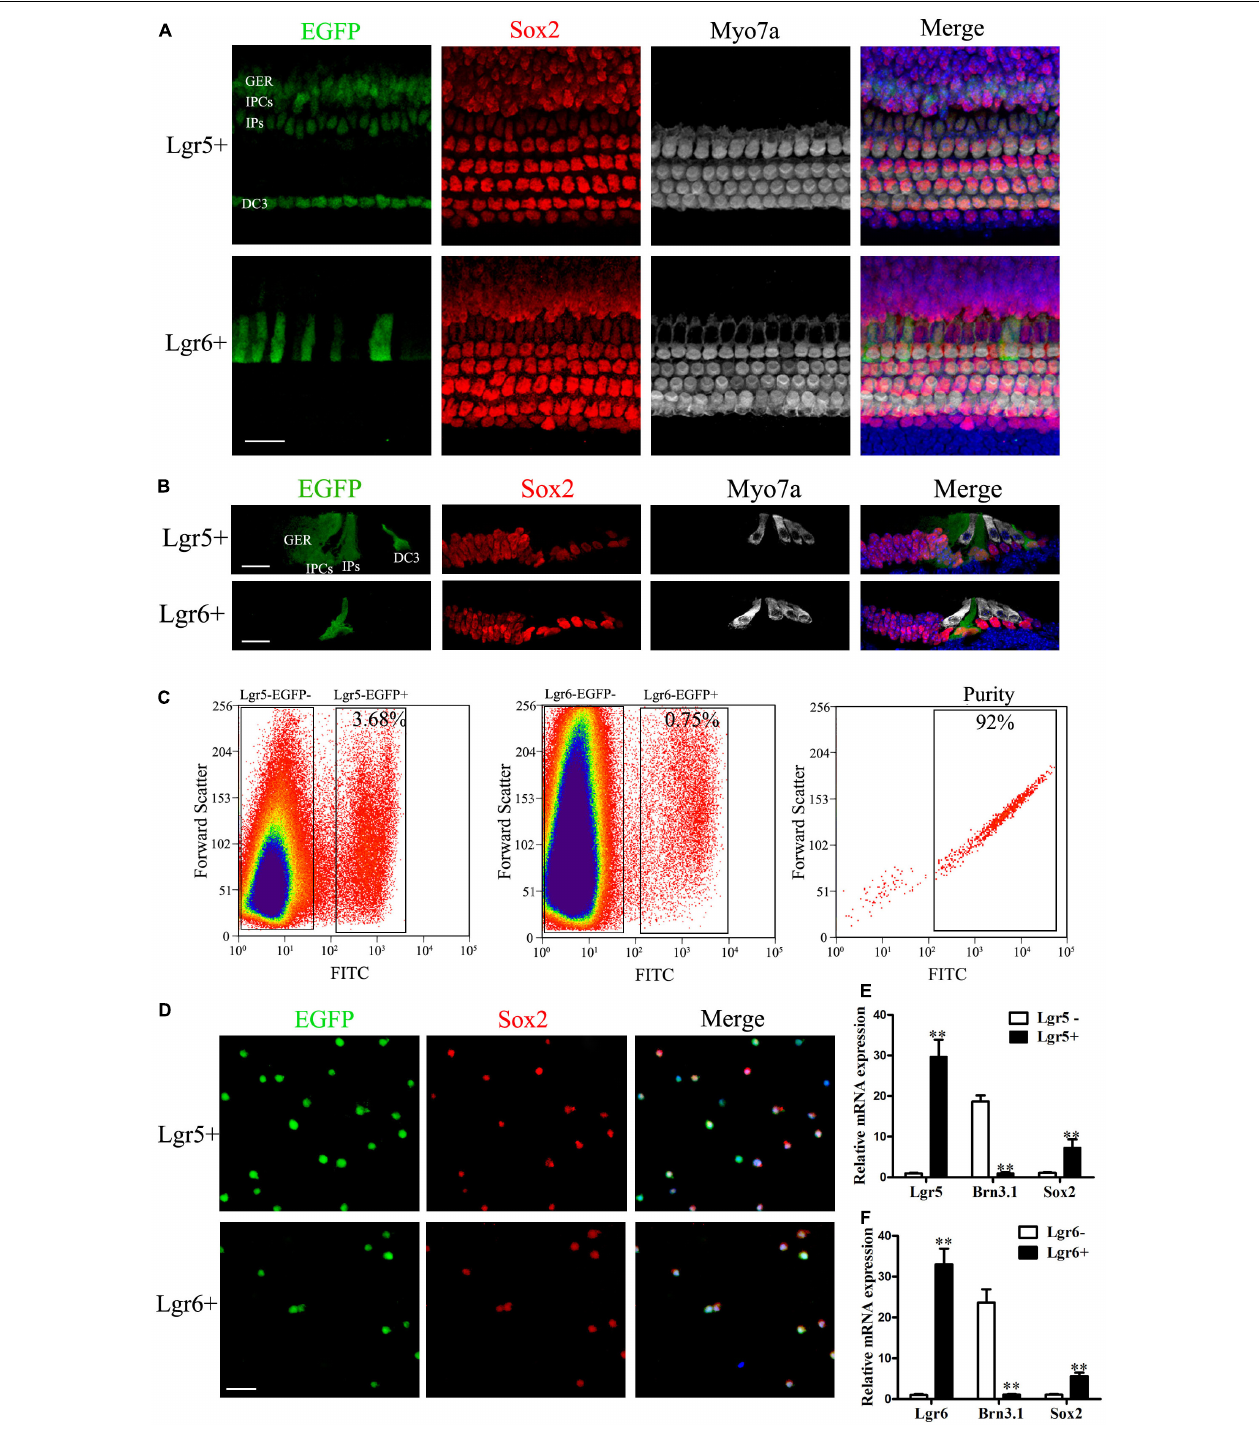
FIGURE 1 | Re-sort analysis, immunostaining, and q-PCR of flow-sorted Lgr5+ and Lgr6+ cells from the postnatal cochlea. (A) At P3, Lgr5 was expressed in the third row of Deiters’ cells (DC3), the inner pillar cells (IPs), the inner phalangeal cells (IPCs), and the lateral GER, while Lgr6 was only expressed in the IPs. (B) Cryosection showed that Lgr5 was expressed in DC3s, IPs, IPCs and the GER, and Lgr6 was only expressed in a subset of IPs in the P3 organ of Corti. (C) GFP+ cells and GFP– cells were isolated using flow cytometry. Re-sort analysis of GFP+ cells demonstrated > 90% purity. (D) Immunostaining of Lgr5+ cells and Lgr6+ cells from the cochlea showed a high percentage of Sox2+ (95.4% and 95.2%, respectively) and GFP+ (95.8% and 96.6%, respectively) cells, and no Myo7a+ cells, among the sorted cells. (E,F) q-PCR showed that isolated Lgr5+ cells and Lgr6+ cells had significantly higher Lgr5 and Lgr6 expression, slightly higher Sox2 expression, and significantly lower Brn3.1 expression compared to the Lgr5- cells and Lgr6– cells, respectively. Scale bars are 20 µ m. ∗∗ p < 0.01.